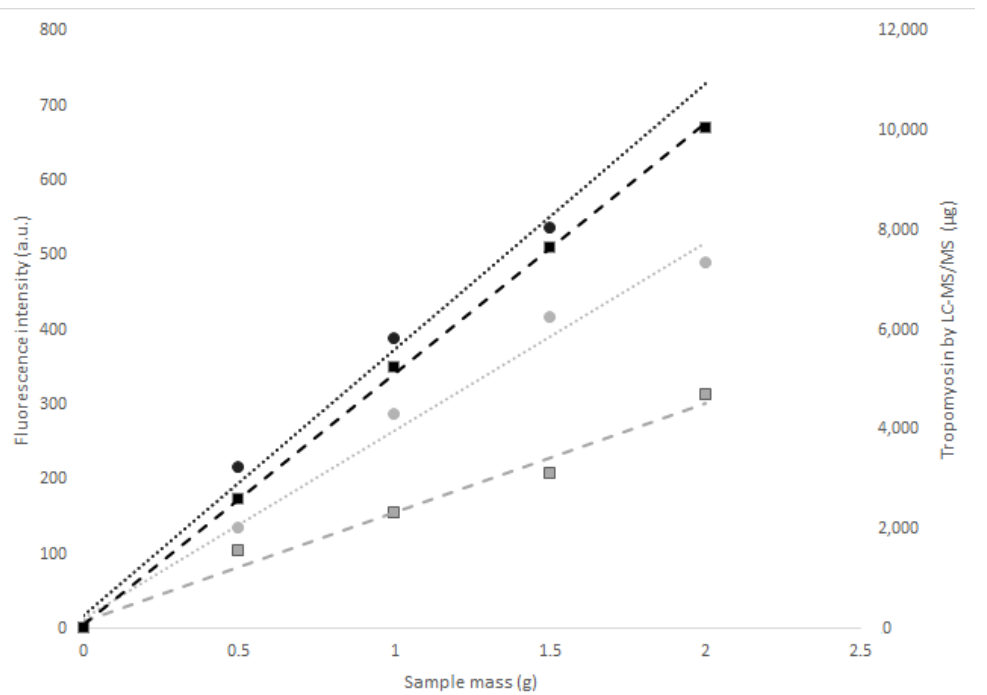
Figure 4. Comparison of calibration curves obtained after application of the MSFIA method based on glutamic acid fluorescence measurements (data represented by circles) and after tropomyosin determination by LC-MS/MS (data represented by squares) on different masses of samples of 2 species of shrimp. In gray: Peneaus vennamei ; in black: Melicertus kerathurus .